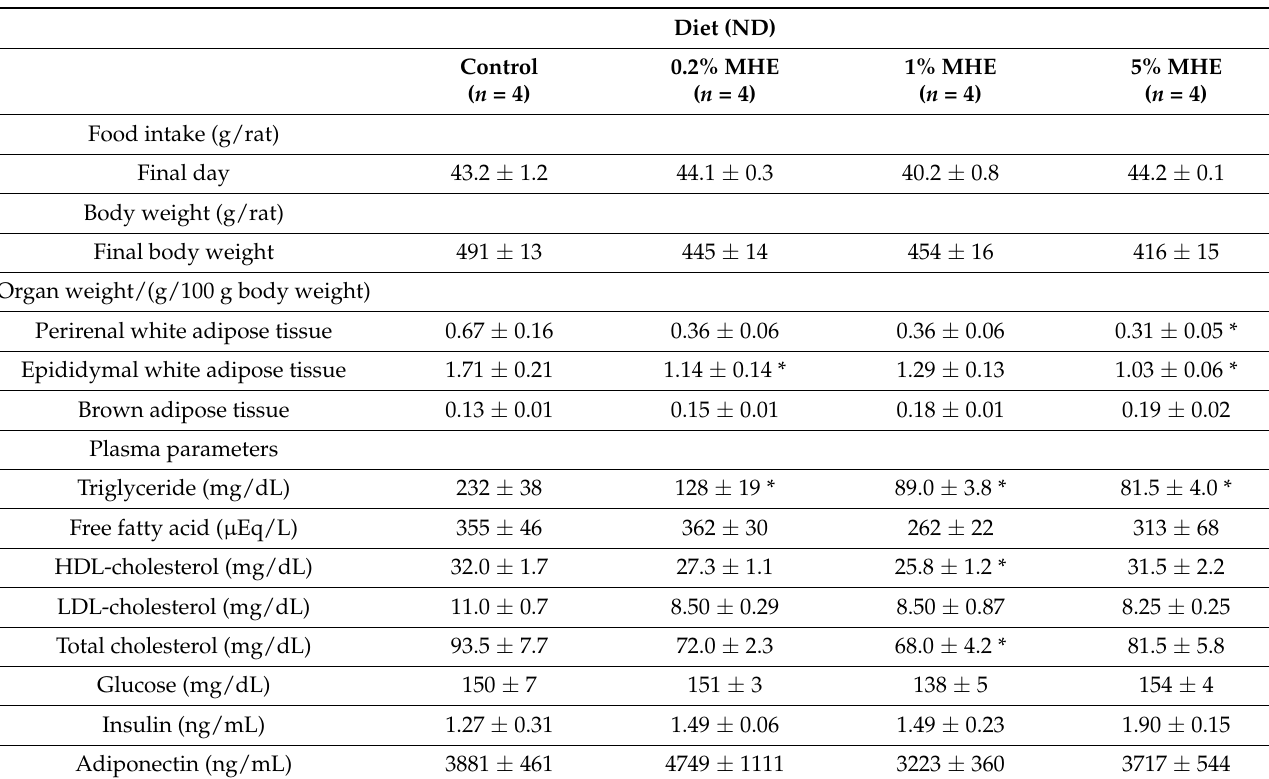
Table 5. Effects of MHE on physical and plasma parameters in ND-fed rats after 10 weeks.